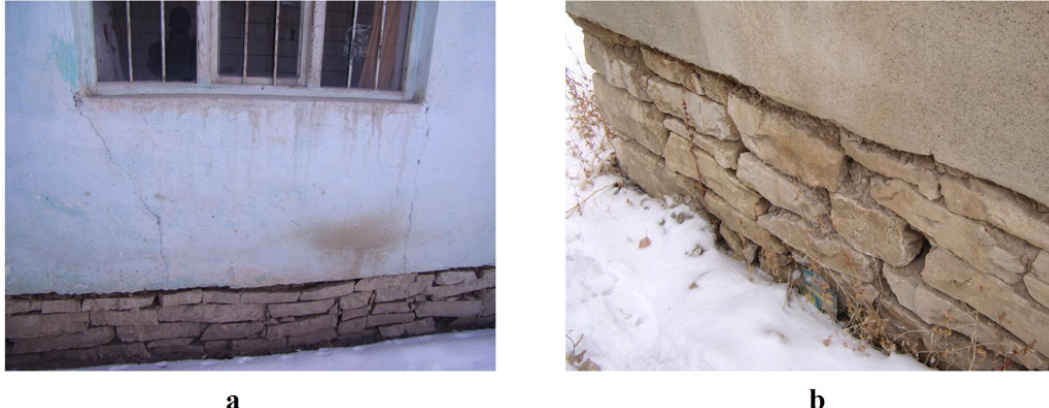
Fig. 13. Views for the typical foundation of a masonry building.